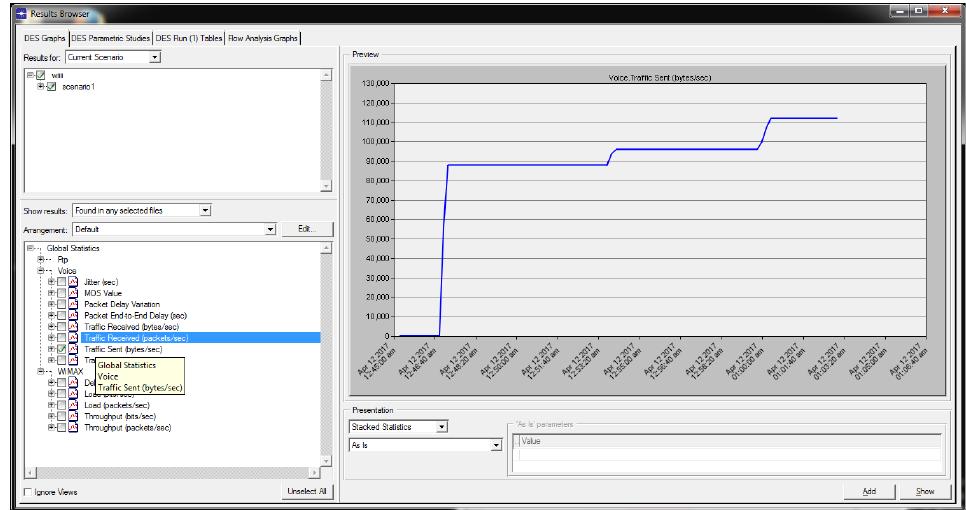
Fig. 11. Global Statistics WiMax VoIP Traffic sent Byte/second for overall network, reaches 18000. It’s a high value competitive with another network connecting this large number of users on a large covering area using only two